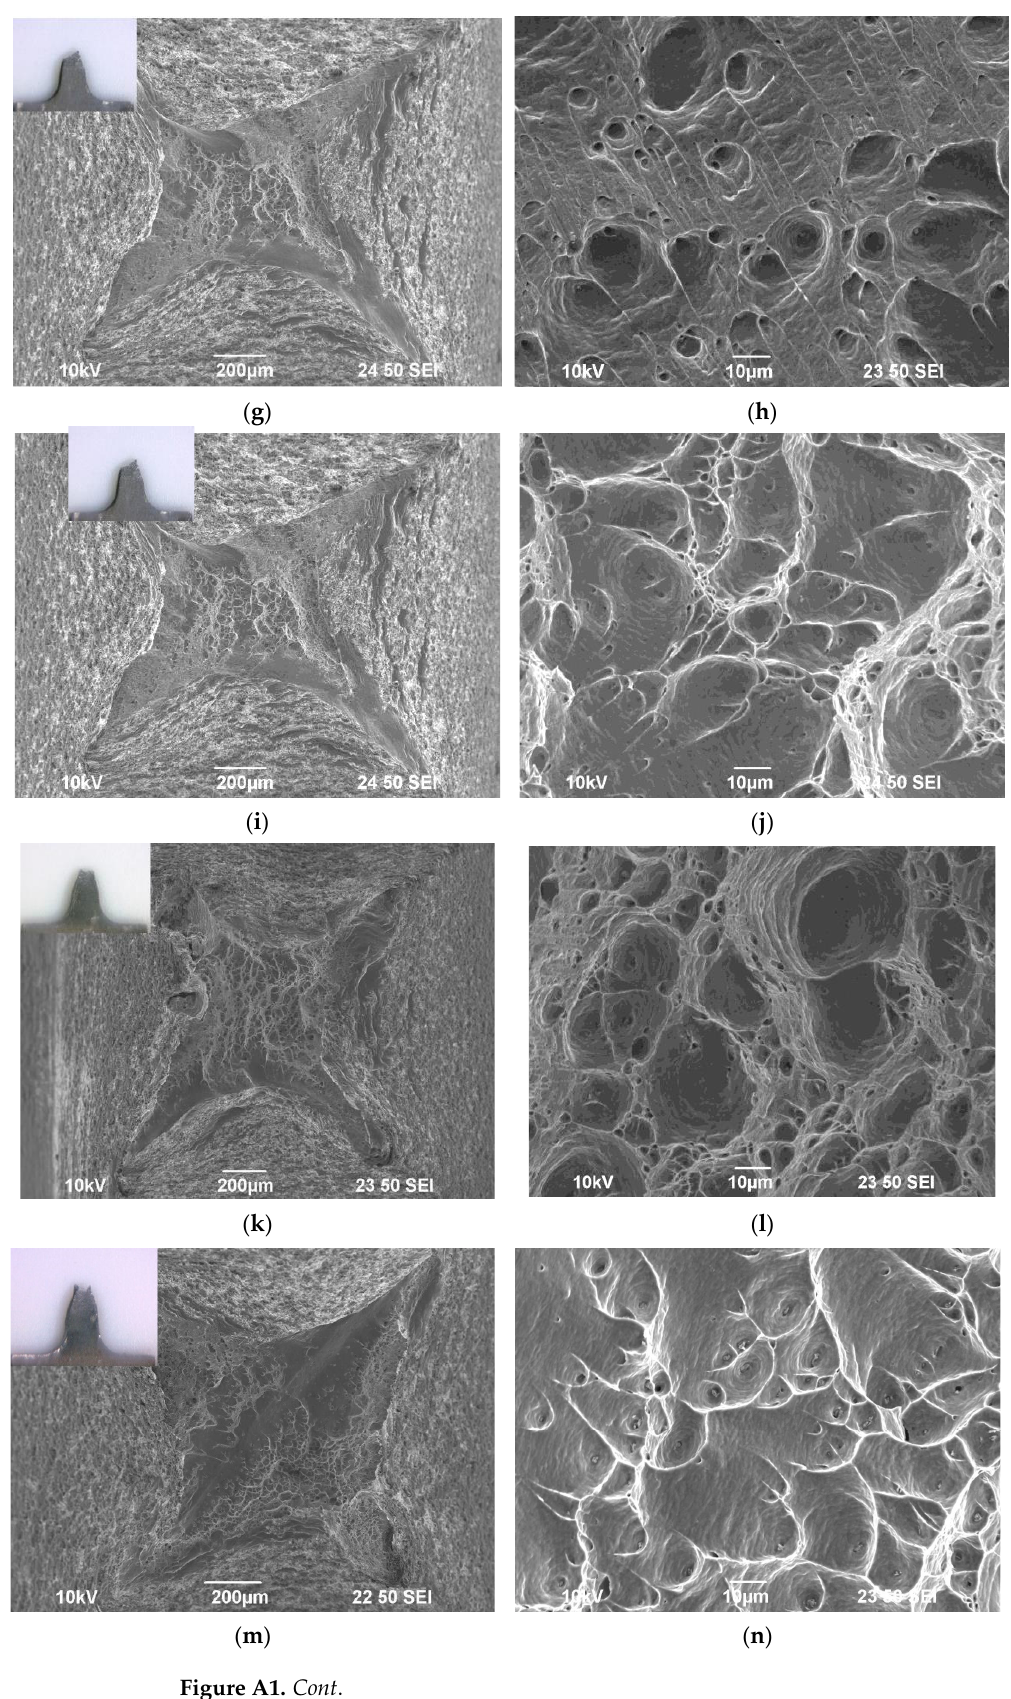
( p ) Figure A1. SEM images of the surface of fractures in alloy specimens No. 1 ( a , b ), 2 ( c , d ), 3 ( e , f ), 4 ( g , h ), 5 ( i , j ), 6 ( k , l ), 7 ( m , n ), and 8 ( o , p ) after tensile tests at room temperature. Appendix B Appendix B shows the stress–strain curves for the UFG alloy specimens tested at elevated temperatures and at a strain rate of 3.3 × 10 − 3 s − 1 . ( a )